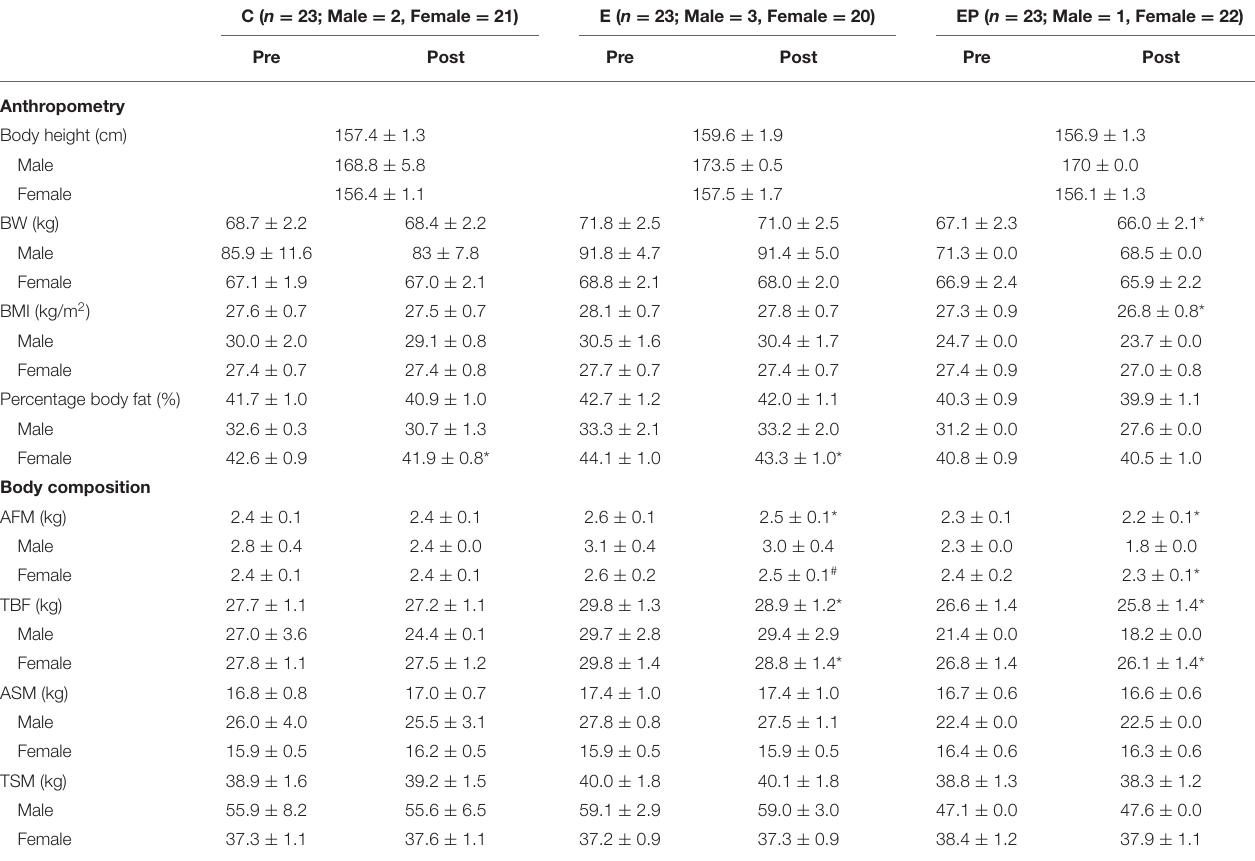
TABLE 1 | Effects of interventions on anthropometry and body composition. C ( n = 23; Male = 2, Female = 21) E ( n = 23; Male = 3, Female = 20) EP ( n = 23; Male = 1, Female = 22)